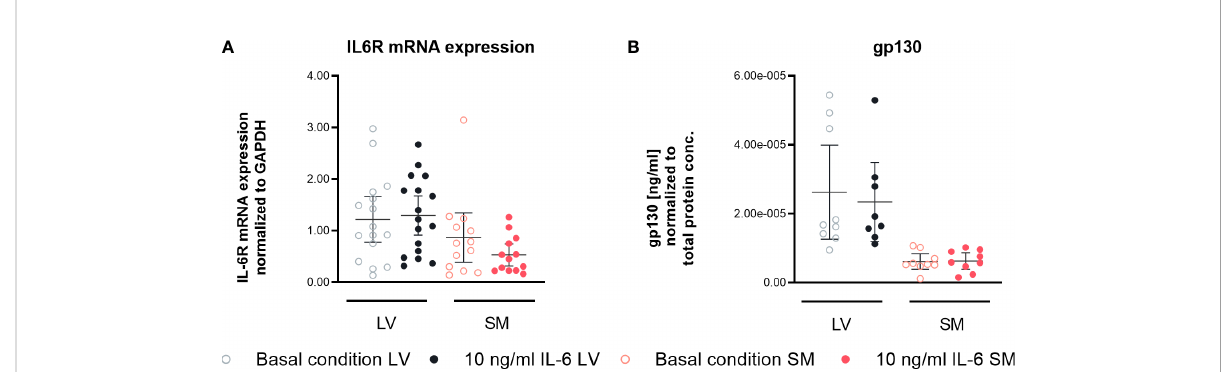
FIGURE 7 IL-6 trans -signaling is differently regulated in left ventricle (LV)- versus skeletal muscle (SM)-derived fi broblasts. (A) IL6R mRNA expression normalized to GAPDH and respective control of LV-derived (black) and SM-derived (red) fi broblasts after 24-h culture with basal medium without IL-6 (basal condition; bright hollow circle) or with 10 ng/ml of IL-6 (dark fi lled circle), n = 18, N = 3, Kruskal – Wallis/one-way ANOVA. (B) Protein expression of gp130 in the supernatant normalized to total protein content measured via bicinchoninic acid assay of LV-derived (black) and SM-derived (red) fi broblasts after 72-h culture with basal medium without IL-6 (basal condition; bright hollow circle) or with 10 ng/ml of IL- 6 (dark fi lled circle). All data are presented as mean ± 95% CI and tested with post-hoc Benjamini – Hochberg